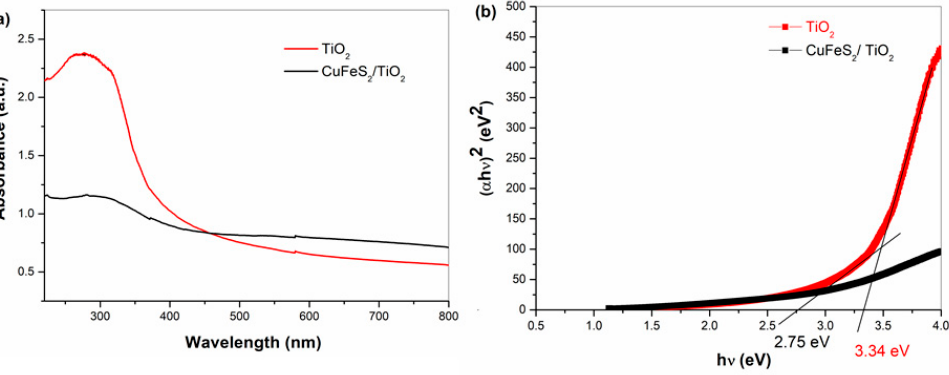
Figure 6. ( a ) UV–Vis spectra and ( b ) Tauc plots for TiO 2 and CuFeS 2 /TiO 2 nanocomposite.